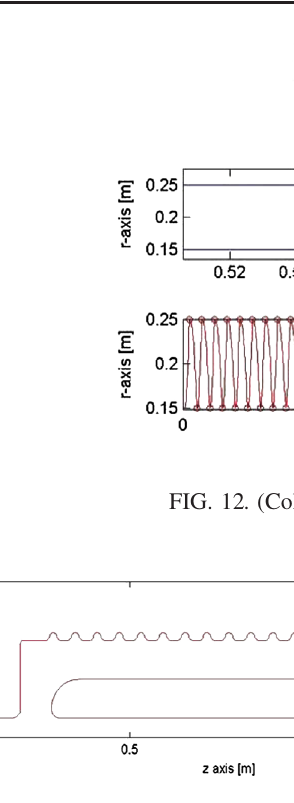
FIG. 13. (Color) Ripples pointing upwards.